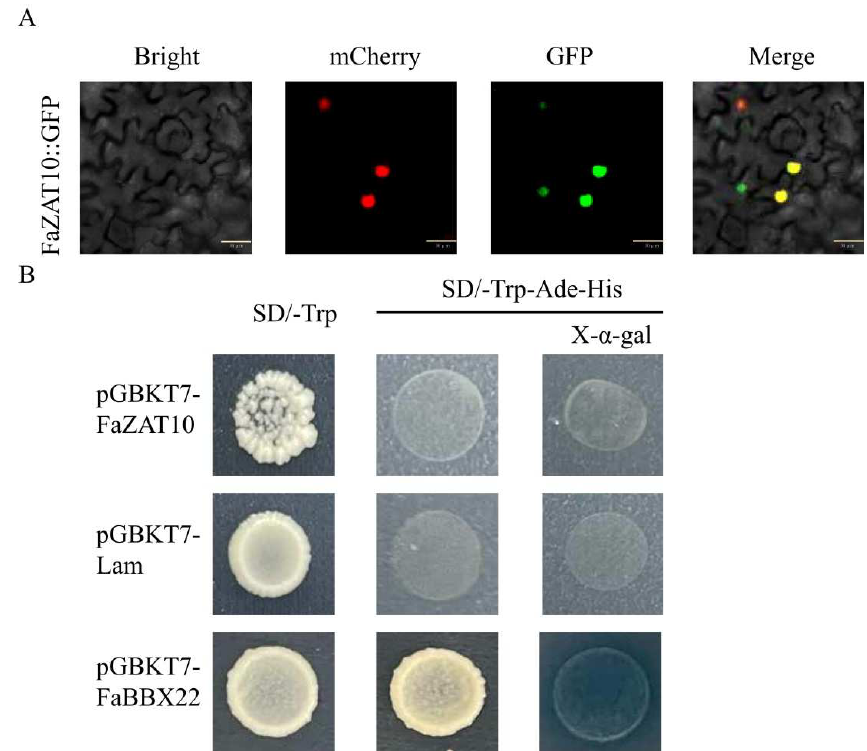
Figure 9. Transcription factor characterization of FaZAT10 . ( A ) Subcellular localization of FaZAT10 protein. Bars, 30 µm. ( B ) Transcriptional activity analysis of FaZAT10 in yeast cells. pGBKT7-Lam is a negative control, and pGBKT7-FaBBX22 is a positive control.